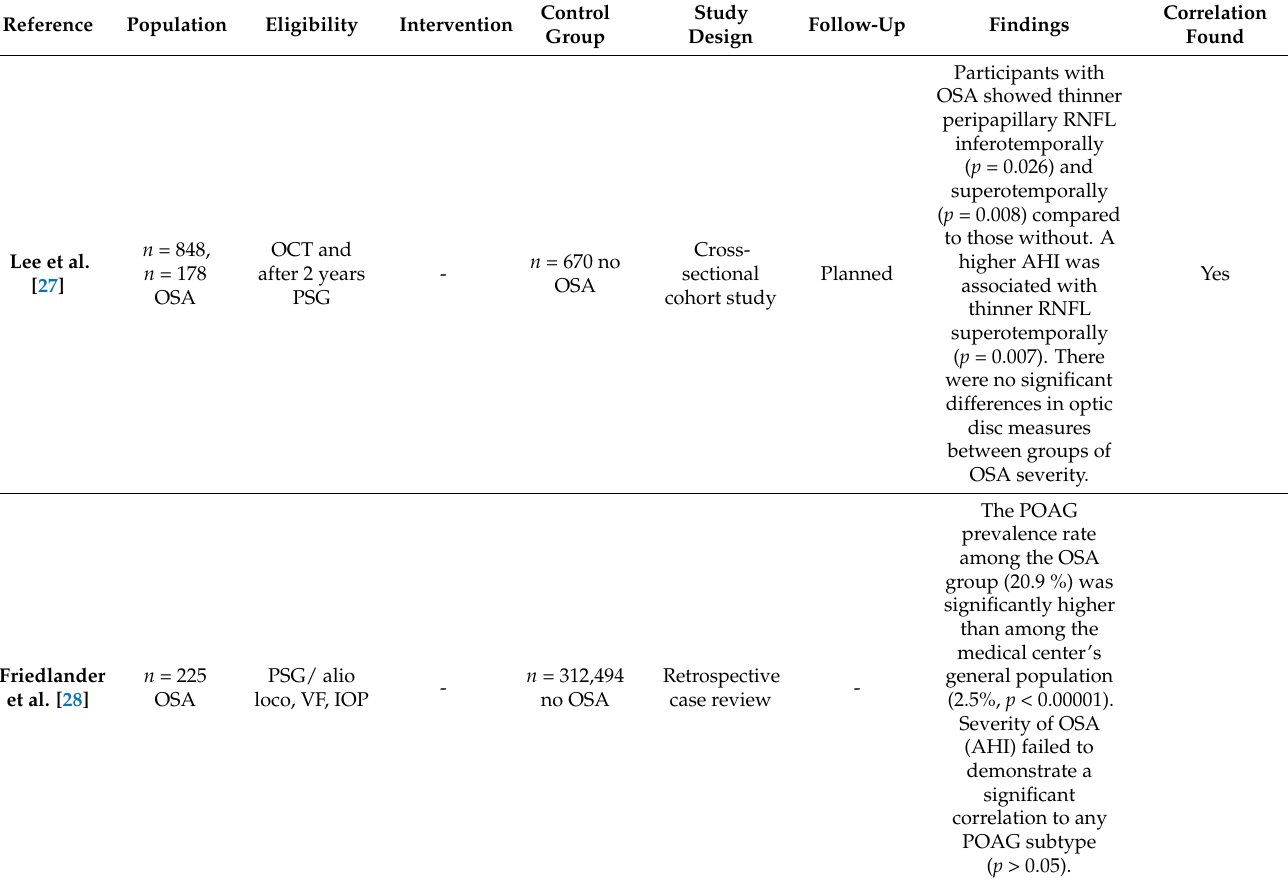
Table 3. Cross-sectional studies and chart reviews to evaluate associations between OSA and glau- coma in the general